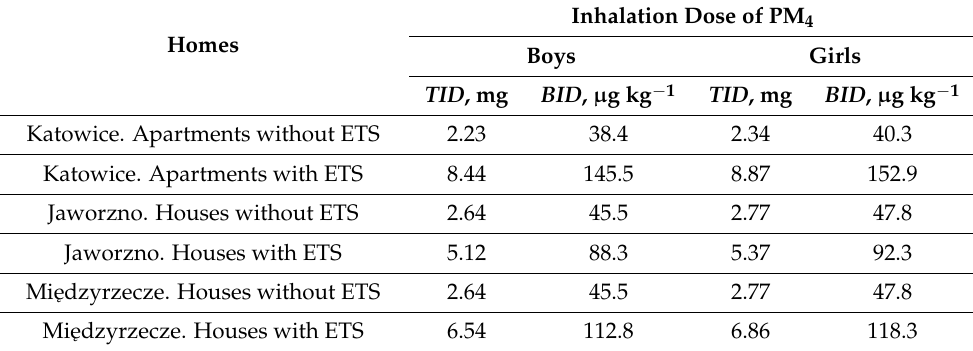
Inhalation Dose of PM 4 Boys